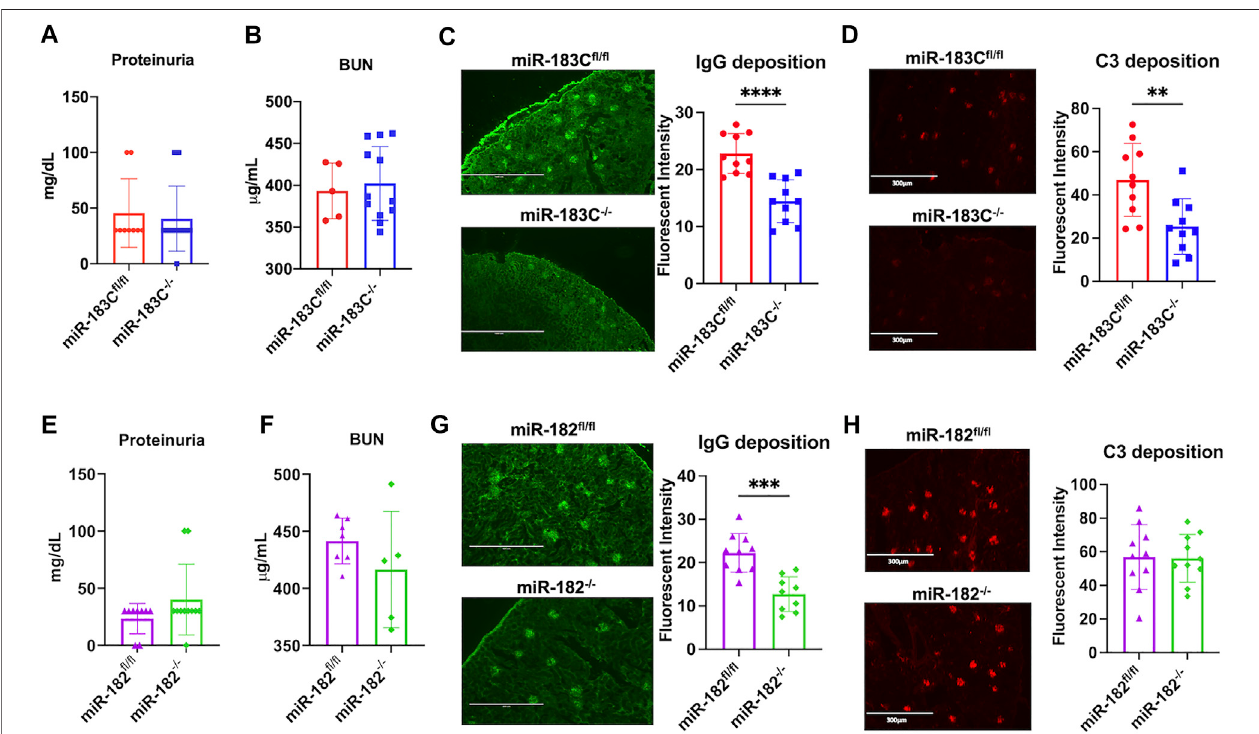
FIGURE 4 | Deletion of either miR-183C or miR-182 alone reduces IgG antibody deposition in kidney. (A,B) Summary graphs show no signi fi cant difference in the proteinuria (A) and blood urea nitrogen (BUN, (B) levels between miR-183C − / − B6/lpr and control miR-183C fl / fl B6/lpr mice. Graphs showed means ± SD ( n ≥ 5) (C,D) Representing IF images and summary data show signi fi cantly reduced IgG (C) and complement C3 (D) immune complex deposition in the kidneys of miR-183C − / − . Graphs showed means ± SD ( n = 10 each) (E,F) Summary graphs show no signi fi cant difference in the proteinuria (E) and blood urea nitrogen (BUN, (F) ) levels between miR-182 − / − B6/lpr and control miR-182 fl / fl B6/lpr mice. Graphs showed means ± SD ( n ≥ 5) (G,H) Representing images and summary data show signi fi cantly reducedIgG (G) andcomplementC3 (H) immunecomplexdepositioninthekidneysofmiR-182 − / − .Graphsshowedmeans±SD( n =10each).Unpairedstudentttests